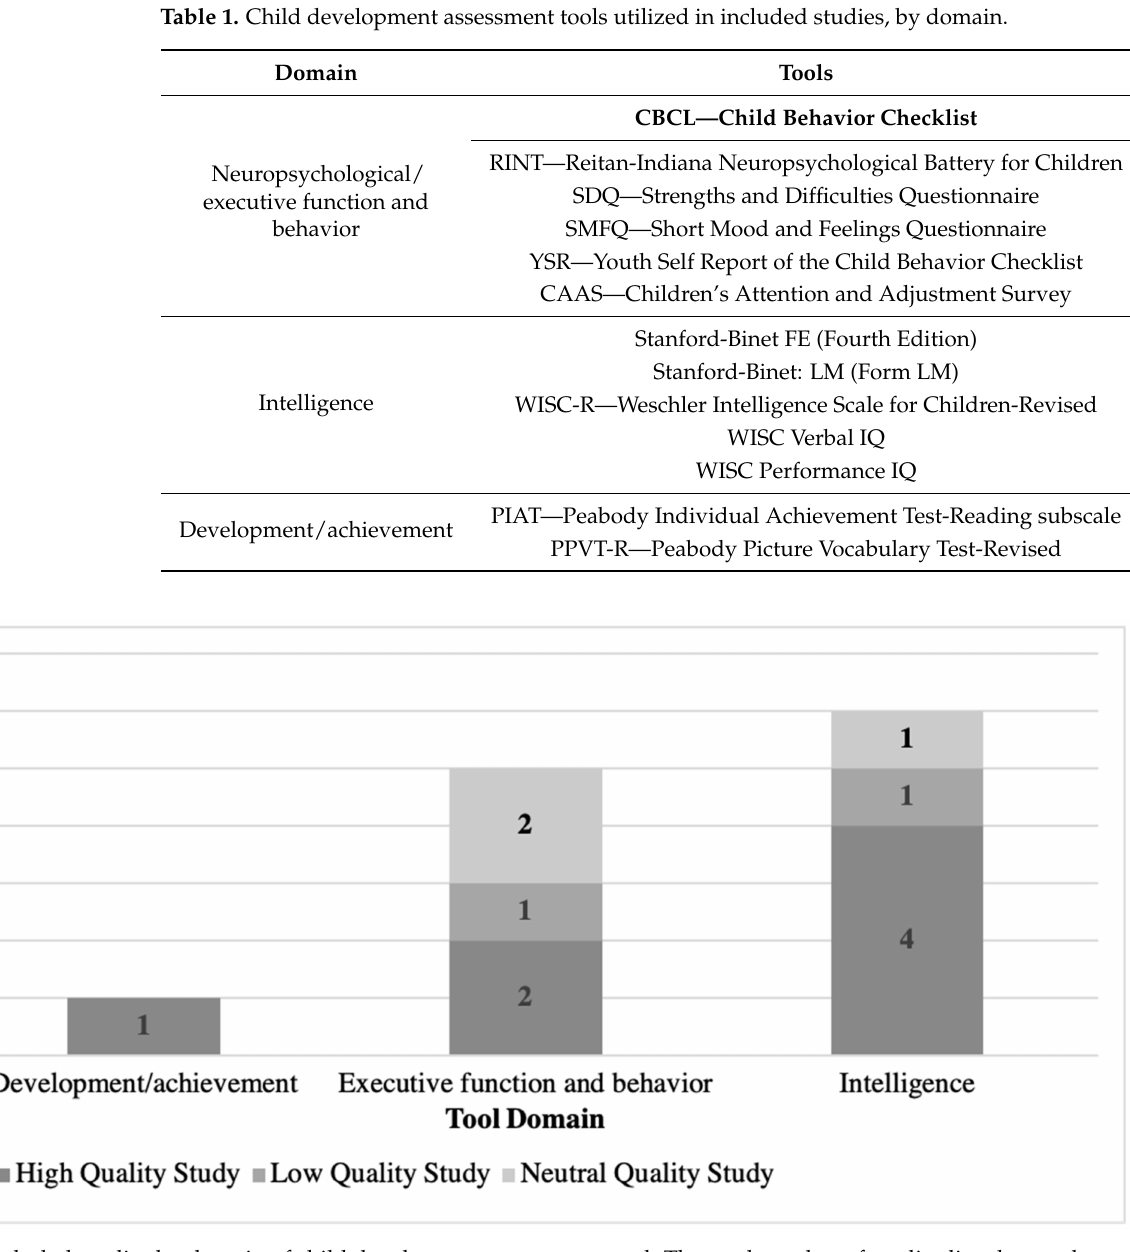
Figure 2. Included studies by domain of child development assessment tool. The total number of studies listed exceeds the number of studies included in this review because [27] included 2 child development assessment tools of interest in 2 domains (Development/achievement and Intelligence). A detailed explanation for the high/neutral/low quality designation is provided in Section 3.4